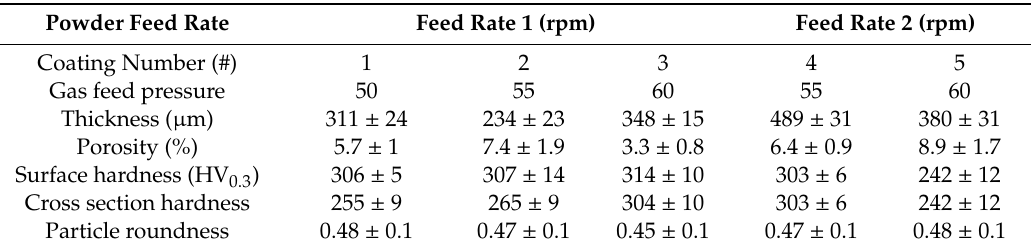
Table 1. Physical properties of